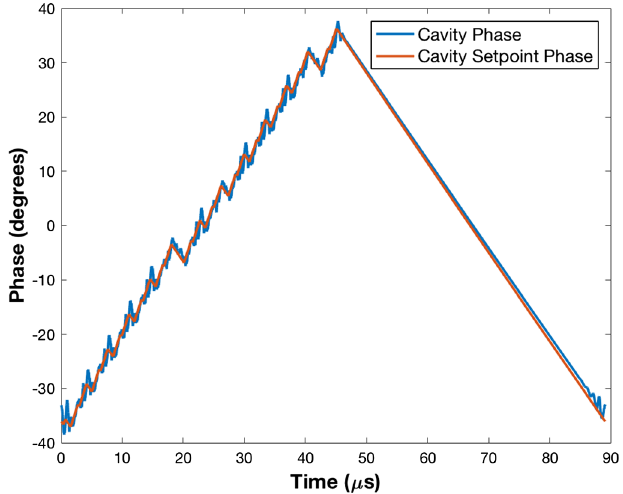
FIG. 6. Simulation of the algorithm with half-full ring. Optimal phase modulation.